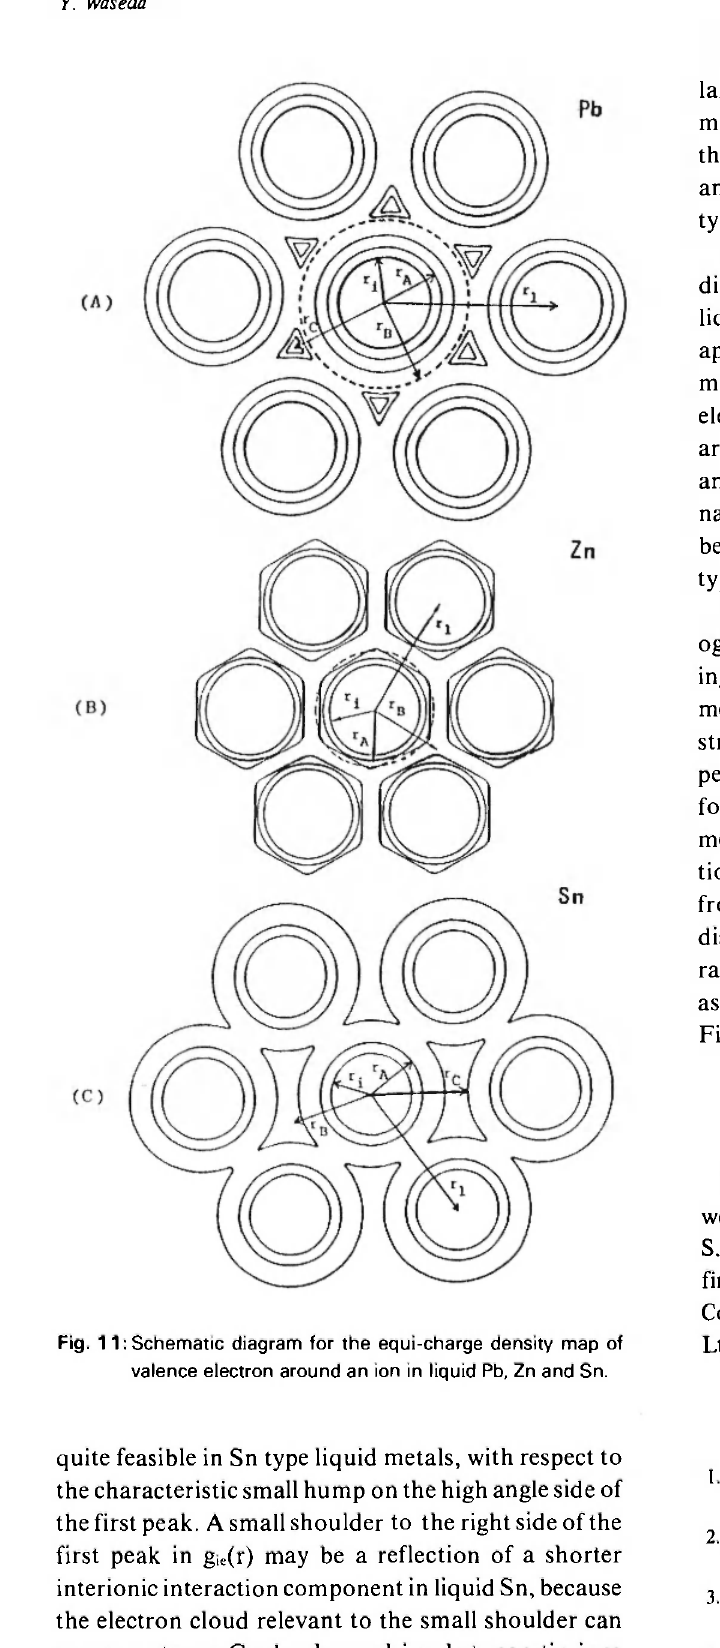
quite feasible in Sn type liquid metals, with respect to the characteristic small hump on the high angle side of the first peak. A small shoulder to the right side of the first peak in g ie (r) may be a reflection of a shorter interionic interaction component in liquid Sn, because the electron cloud relevant to the small shoulder can screen a strong Coulomb repulsion between tin ions located in the neighbouring region. Inhomogeneous valence electron distribution, including the